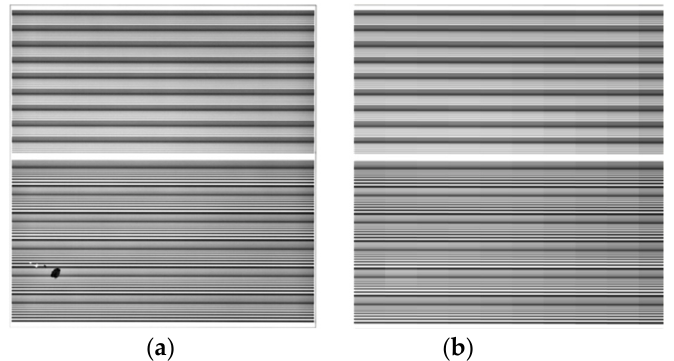
Figure 13. ( a ) Original image of Block 5; ( b ) the defect-free image of ( a ) obtained by using one-dimensional median filtering.